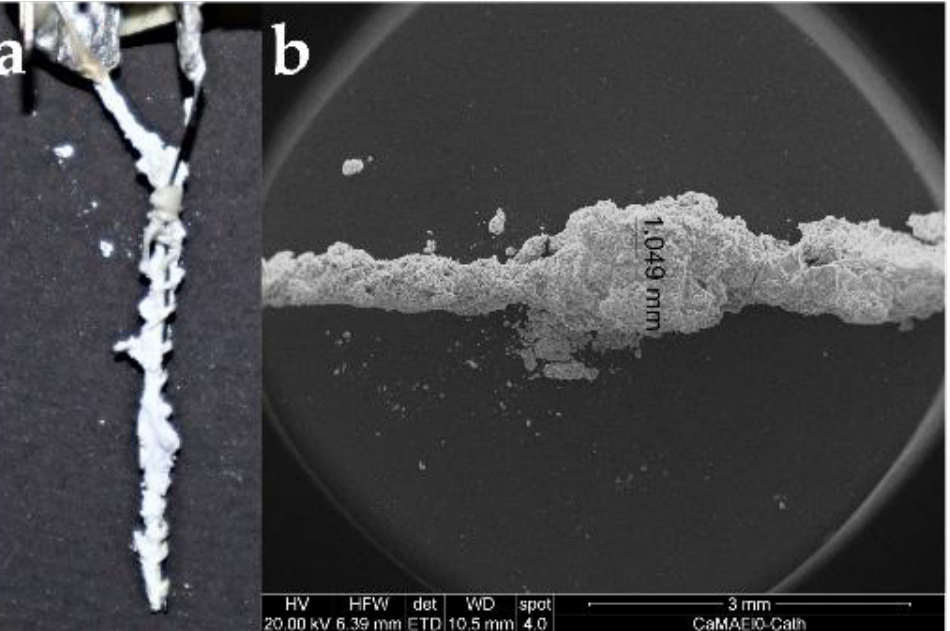
Figure 9. Precipitation of brushite by a BDD electrode. Initial deposition of CaP at the cathode surface. ( a ) Cathode of the “wound-wire electrode” covered in precipitate. Please note that the anode is free of precipitate. ( b ) SEM micrograph of precipitate formed after a few seconds of current applied. Parameters are shown in the box at the bottom. ETD: Everhart-Thornley detector.